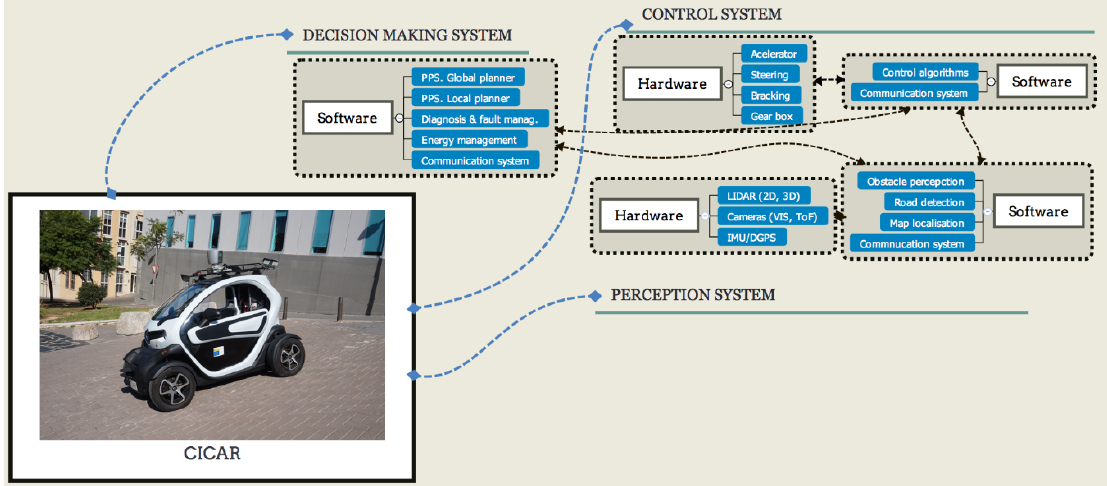
Figure 3. Distribution of the high ‐ level architecture components of the CICar.